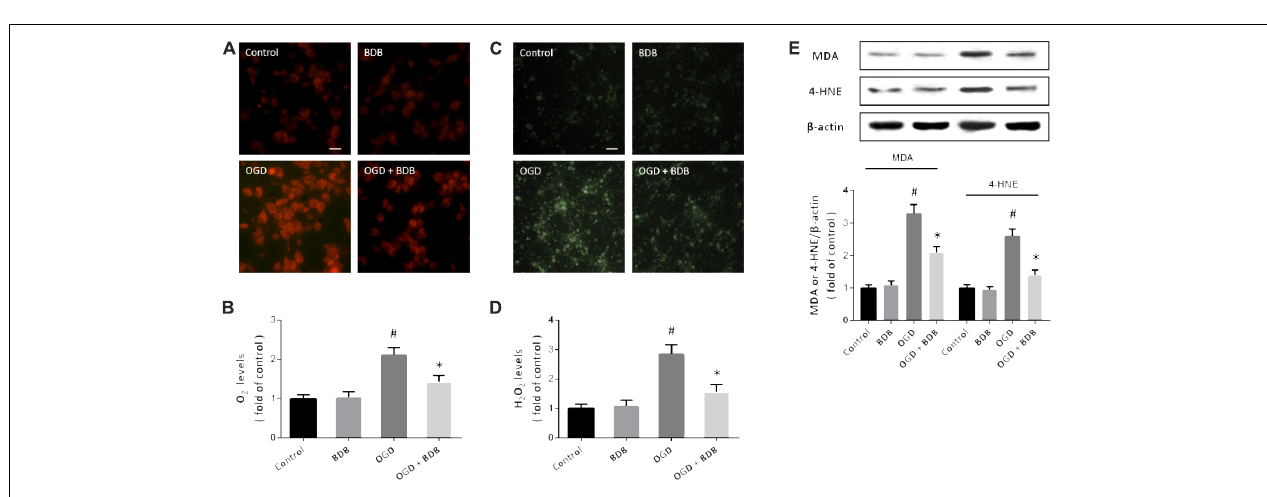
FIGURE 1 | BDB attenuates ischemic injury in cardiomyocytes. (A) WST-1 assay shows that BDB attenuated the decrease in cell viability induced by OGD. (B) LDH release assay shows that BDB reduced the increase in LDH release induced by OGD. (C,D) Flow cytometry (C) and quantification (D) show that BDB inhibited apoptosis induced by OGD. (E) Western blot shows that BDB inhibited caspase-3 activation induced by OGD. Data are shown as mean ± SEM ( n = 6). # p < 0.05 vs. Control. ∗ p < 0.05 vs. OGD.